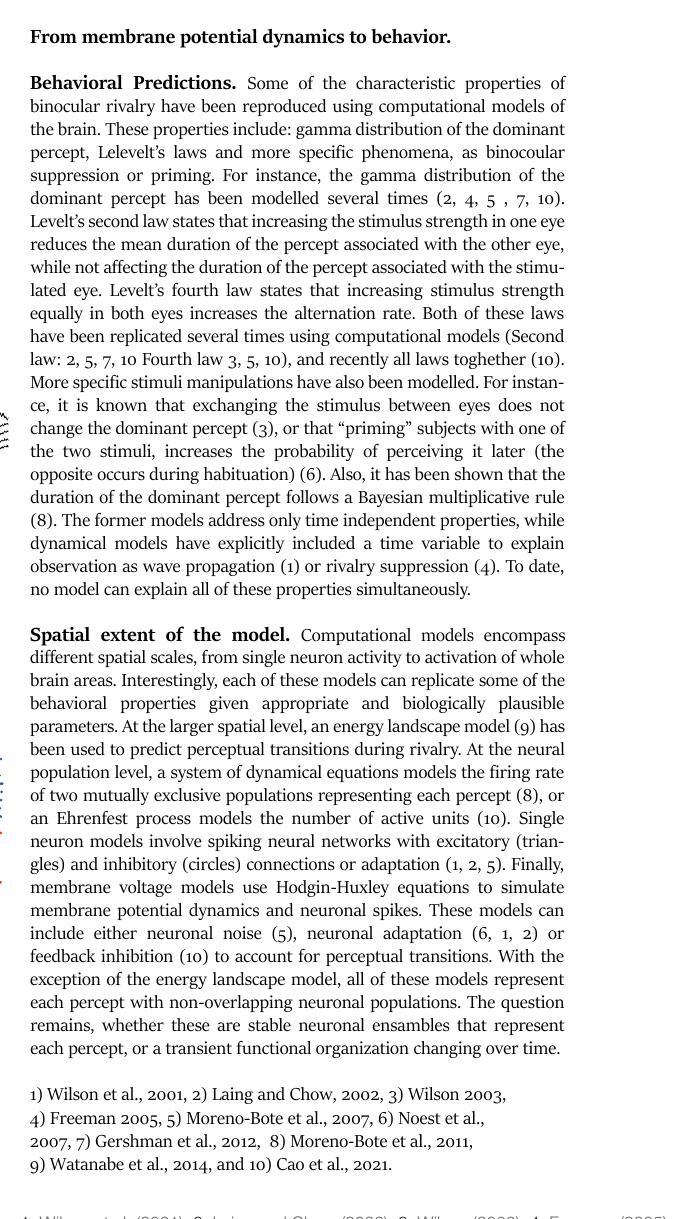
FIGURE 2 | From membrane potential dynamics to behaviour. Reference: 1, Wilson et al. (2001); 2, Laing and Chow (2002); 3, Wilson (2003); 4, Freeman (2005); 5, Moreno-Bote et al. (2007); 6, Noest et al. (2007); 7, Gershman et al. (2012); 8, Moreno-Bote et al. (2011); 9, Watanabe et al. (2014): and 10) Cao et al. (2021).